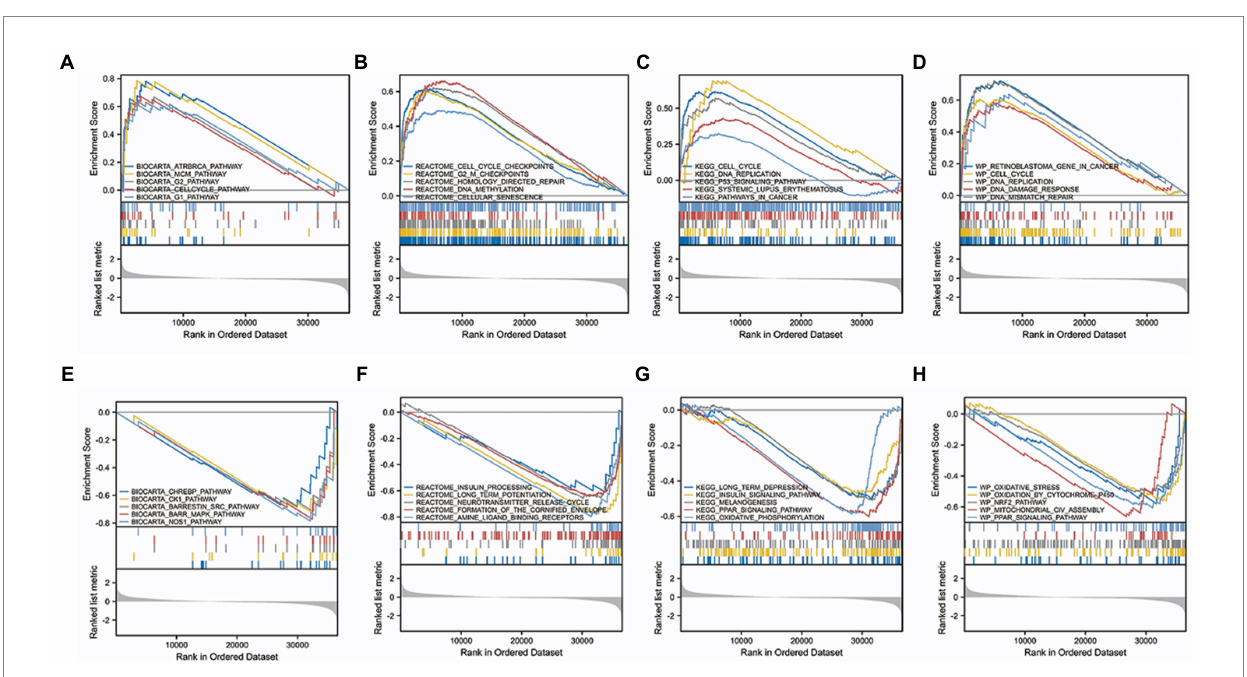
FIGURE 15 GSEA of TMEM131L. GSEA results of differential TMEM131L expression. Enrichment of TMEM131L with high (A–D) and low (E–H) expression in BIOCARTA, REACTOME, KEGG, and